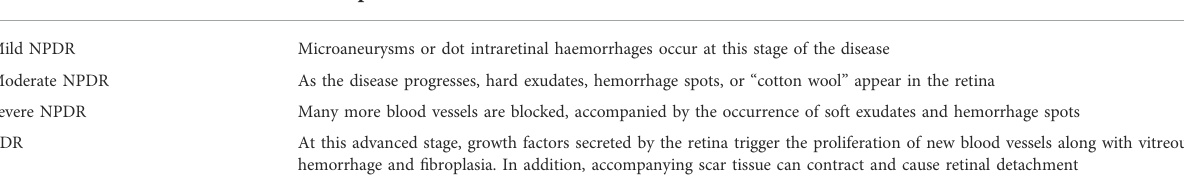
TABLE 1 Stages of diabetic